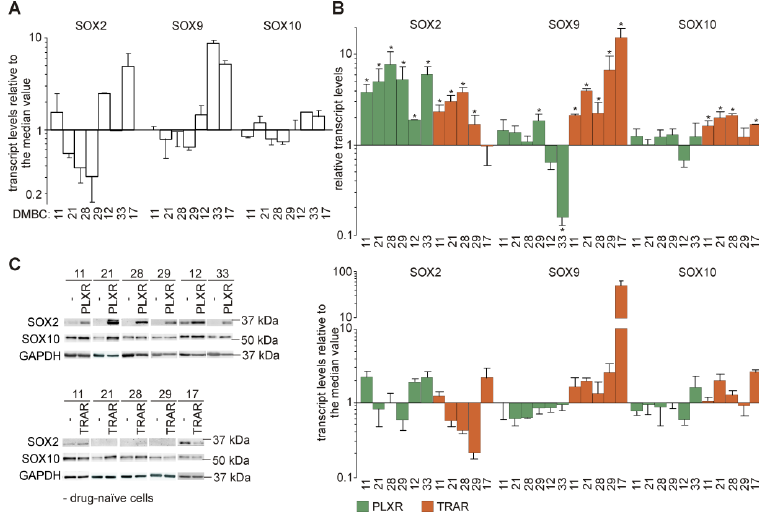
Figure 2. Drug-naïve and their drug-resistant counterparts di ff er in expression of genes of the SOX family. ( A ) Transcript levels of indicated genes determined in drug-naïve cells by qRT-PCR are shown relative to the median value in all seven cell lines. ( B ) Upper part: expression of SOX2 , SOX9 and SOX10 assessed in vemurafenib-resistant (PLXR) and trametinib-resistant (TRAR) cell lines by qRT-PCR is shown relative to expression of these genes in the matched drug-naïve cells. Bars represent mean values of 3 biological replicates ± SD, except for 12_PLXR cells ( n = 2). Di ff erences are considered significant at * p < 0.05. Lower part: transcript level in each cell line was related to the median value calculated for all 11 resistant cell lines. ( C ) Proteins levels of SOX2 and SOX10 were determined in drug-naïve, PLXR and TRAR cell lines by Western blotting. GAPDH was used as a loading control; n = 3, except for 12_PLXR cells ( n =